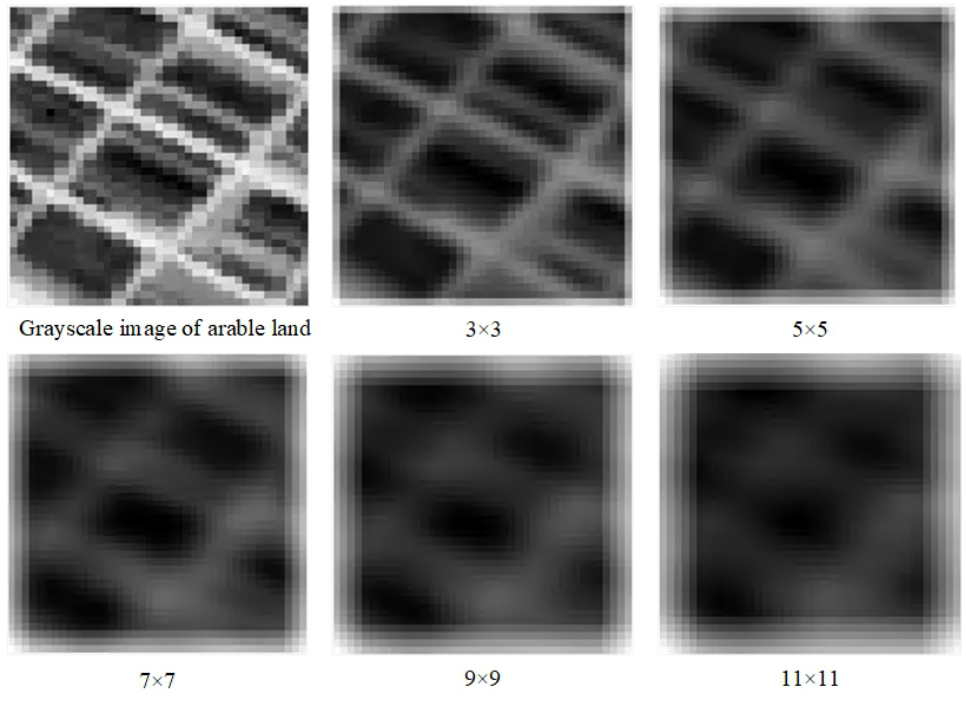
Figure 7. Different scale feature map of cultivated